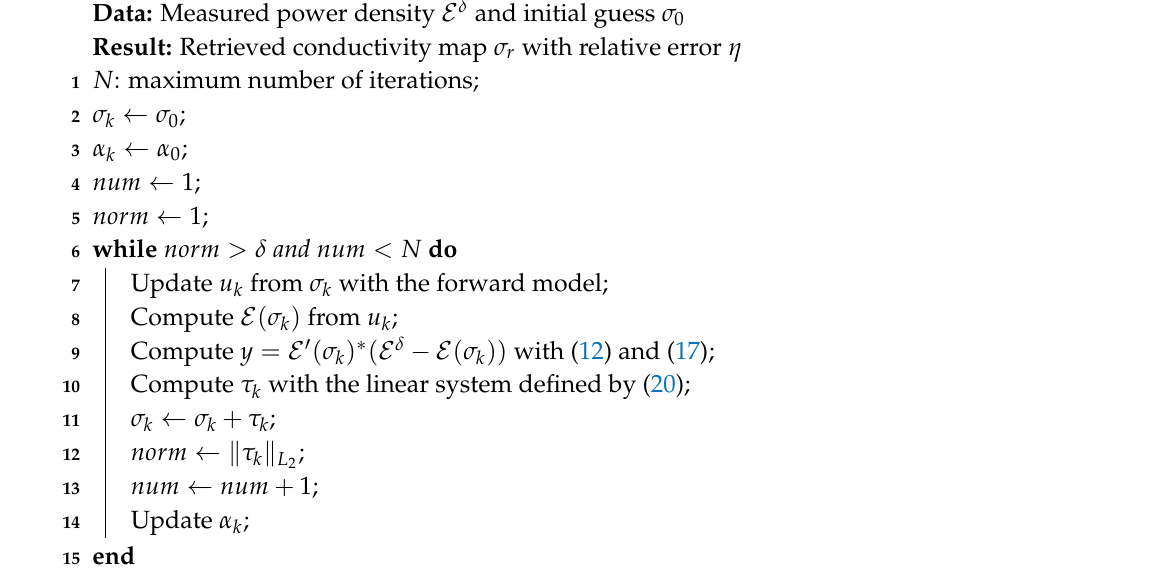
Algorithm 1: LM-CM algorithm for retrieving the conductivity map of a domain Ω from a single measurement of power